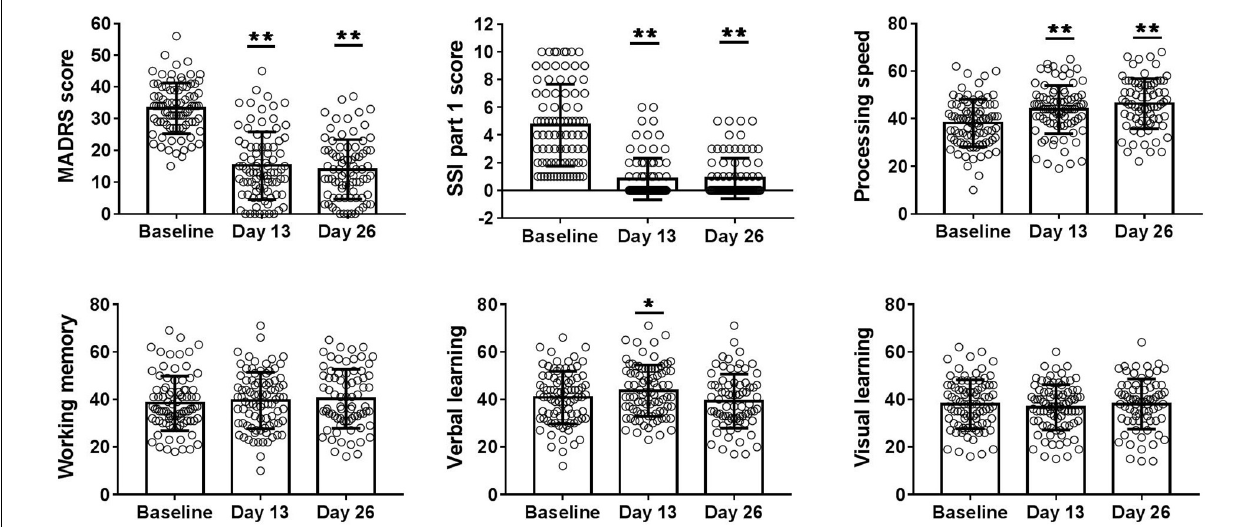
FIGURE 1 | Overall change in MADRS score, SSI part 1 score, T score of processing speed, working memory, visual learning, and verbal learning from baseline to days 13 and 26. A main effect of ketamine treatment was observed in depressive symptoms, suicide ideation, processing speed, and verbal learning performance. MADRS, Montgomery-Asberg Depression Rating Scale; SSI part 1, the first five items of Beck Scale for Suicide Ideation. * P < 0.05, ** P < 0.001. All p -values represent the results of retrospective analyses compared with